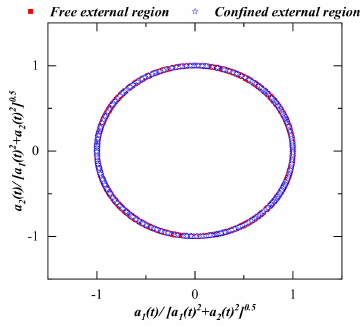
Figure 17. Scatter distribution of time coe ffi cients a 1 (t) vs. a 2 (t) at Re =